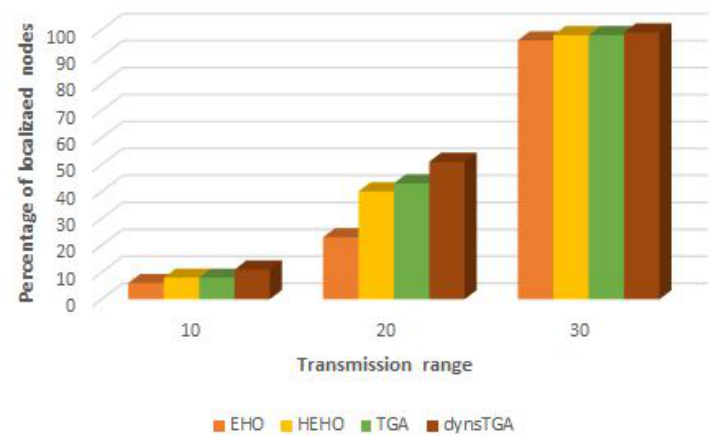
Figure 9. Percentage of localized nodes vs. transmission range.